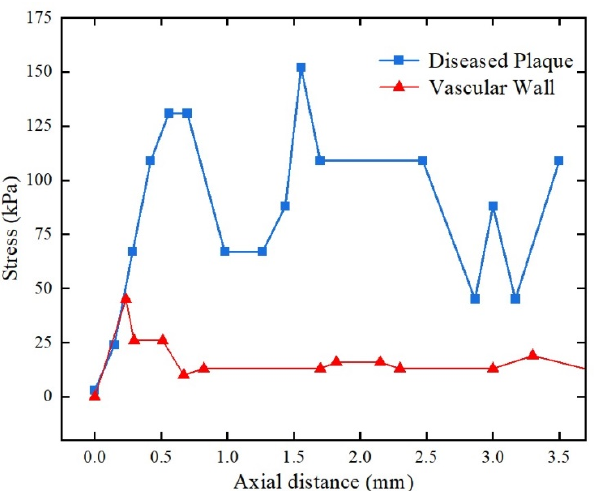
Figure 14. Distribution of stress along the axes of plaque and artery vessel wall.